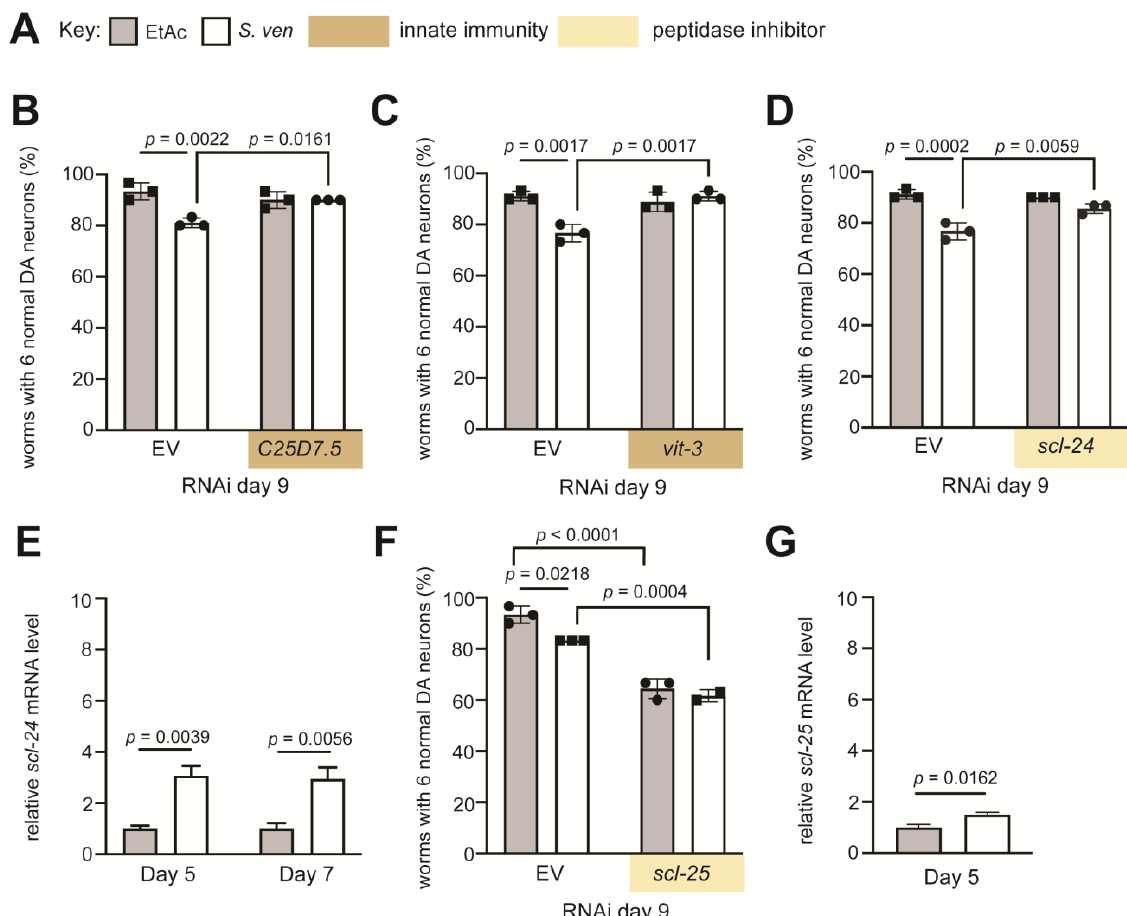
Figure 4. RNAi knockdown of innate immunity genes attenuates S. ven -induced DA neurodegeneration in C. elegans . ( A ) Key denoting gray bars represent EtAc, white bars represent S. ven treatment, tan represents genes associated with innate immunity, and light yellow indicates genes associated with peptidase inhibitor activity. ( B – D , F ) DA neurodegeneration analysis in P dat-1 ::GFP day 9 adult animals following RNAi of genes associated with either innate immunity ( B , C ) or peptidase inhibitor activity ( D , F ). ( B ) C25D7.5 and ( C ) vit - 3 results in decreased DA neurodegeneration following S. ven metabolite exposure. ( D ) Loss of peptidase inhibitor scl-24 results in decreased DA neurodegeneration in animals exposed to S. ven metabolite. ( F ) Loss of peptidase inhibitor scl - 25 results in enhanced DA neurodegeneration in animals following S. ven exposure. Neurodegenerative represented as mean +/ − SD. Data analyzed by two-way ANOVA with Tukey’s post hoc test (n = 30 animals/rep; 3 biological replicates). ( E , G ) Quantification of mRNA gene expression levels of peptidase inhibitors ( E ) scl - 24 and ( G ) scl - 25 on adult day 5 or 7 worms following exposure to either EtAc or S. ven metabolite. mRNA data analyzed by one-tailed Student’s t -test and presented as mean +/ − SEM of three biological replicates, with three technical replicates each; at least 100 animals were used for each replicate. All RT-qPCR data normalized to EtAc control. Significance is represented by exact p -values.